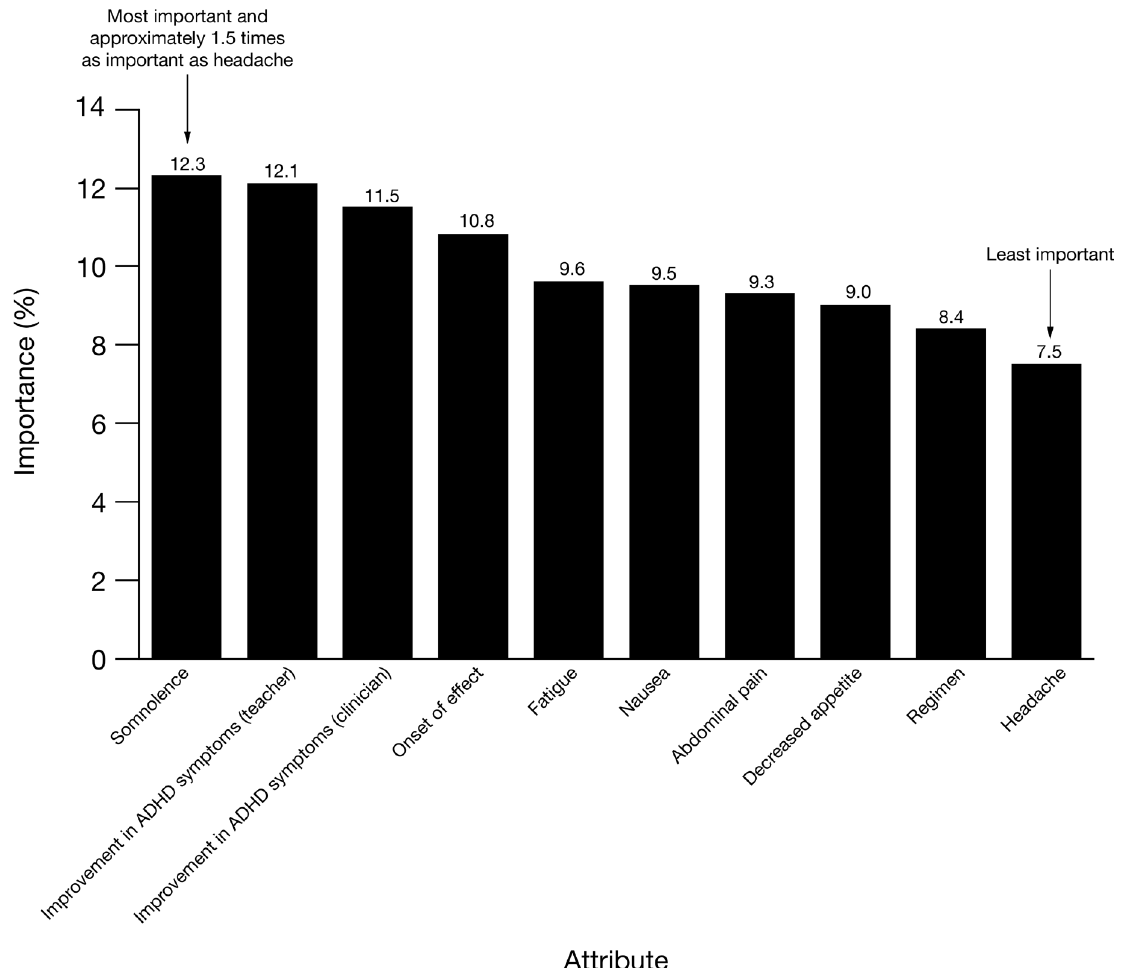
Figure 3. Mean Percent Importance Ratings for Attributes among Children/Adolescents